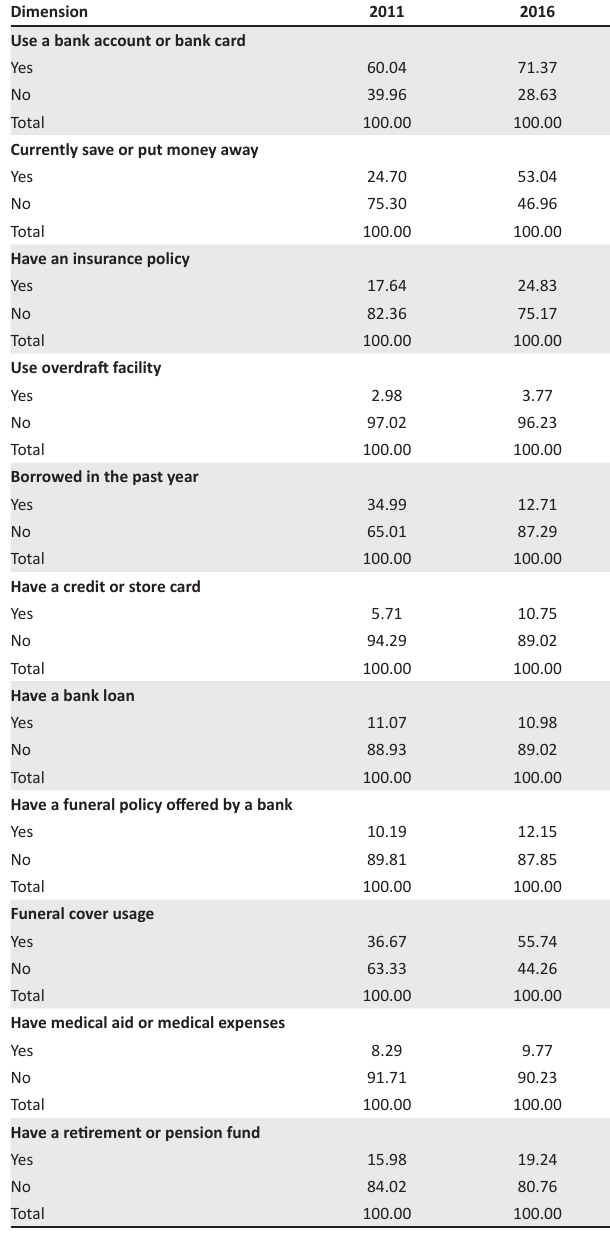
TABLE 1-A1: Description of data on the access dimension of financial inclusion ( % ). Dimension 2011 Overall banking status